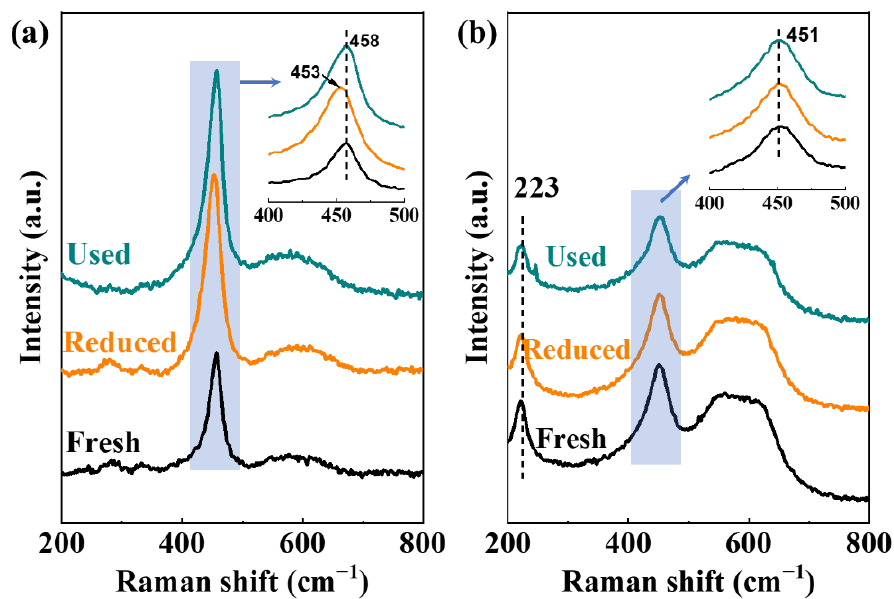
Figure 5. Raman spectra of fresh, reduced and used ( a ) FSP-CuCe and ( b ) CP-CuCe catalysts. The magnification of CeO 2 F 2g peak is shown as inserts.